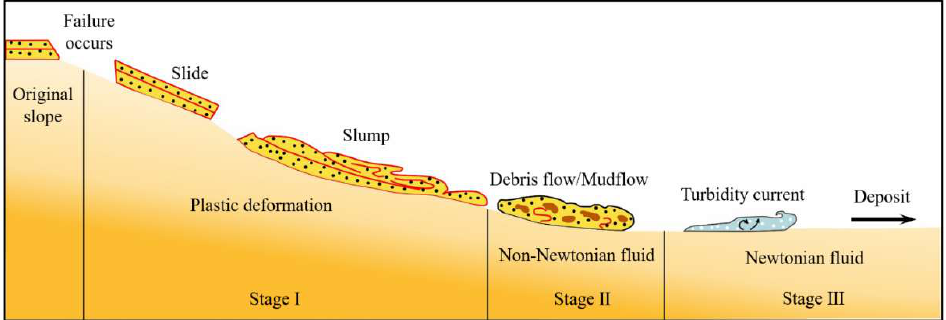
Figure 1. Evolution process of a submarine landslide (adapted with permission from Ref. [8]. 2021, Xing-sen Guo).